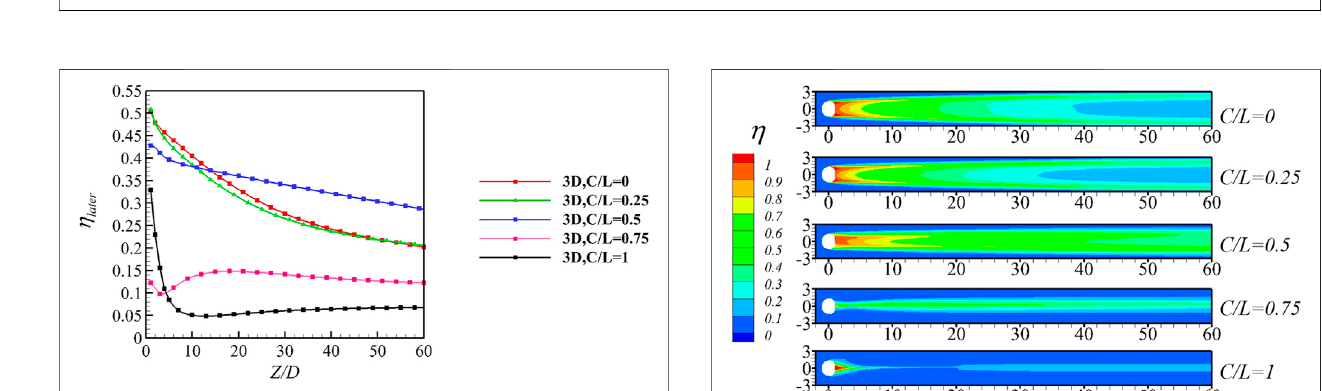
FIGURE 12 | X-direction vorticity contour and streamline at X/D (cid:2) 2 plane in M (cid:2) 1.5 condition.